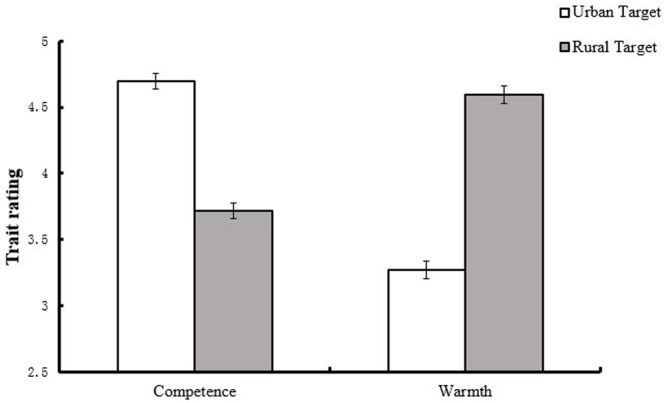
Evaluation of warmth and competence as a function of target and judge. Error bars represent standard error of means.